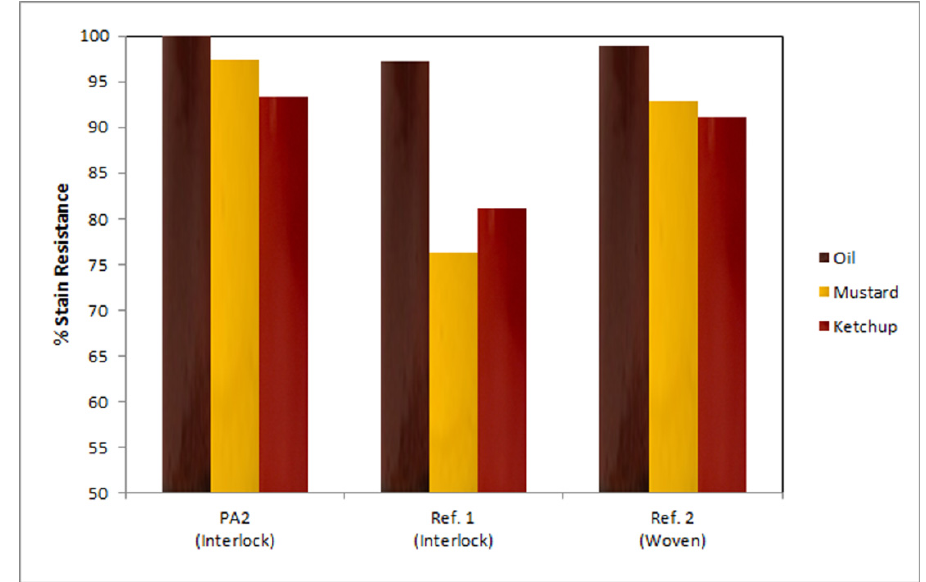
Figure 10. Stain resistance comparison for PA2 and commercial fabrics with different